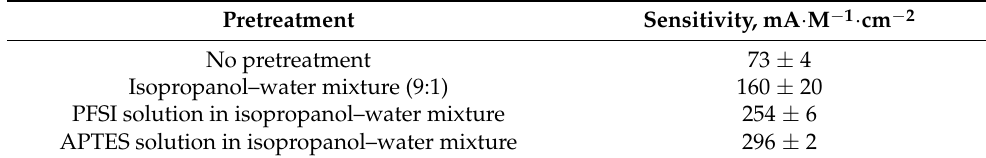
Table 2. Analytical performance for printed hydrogen peroxide sensors with different